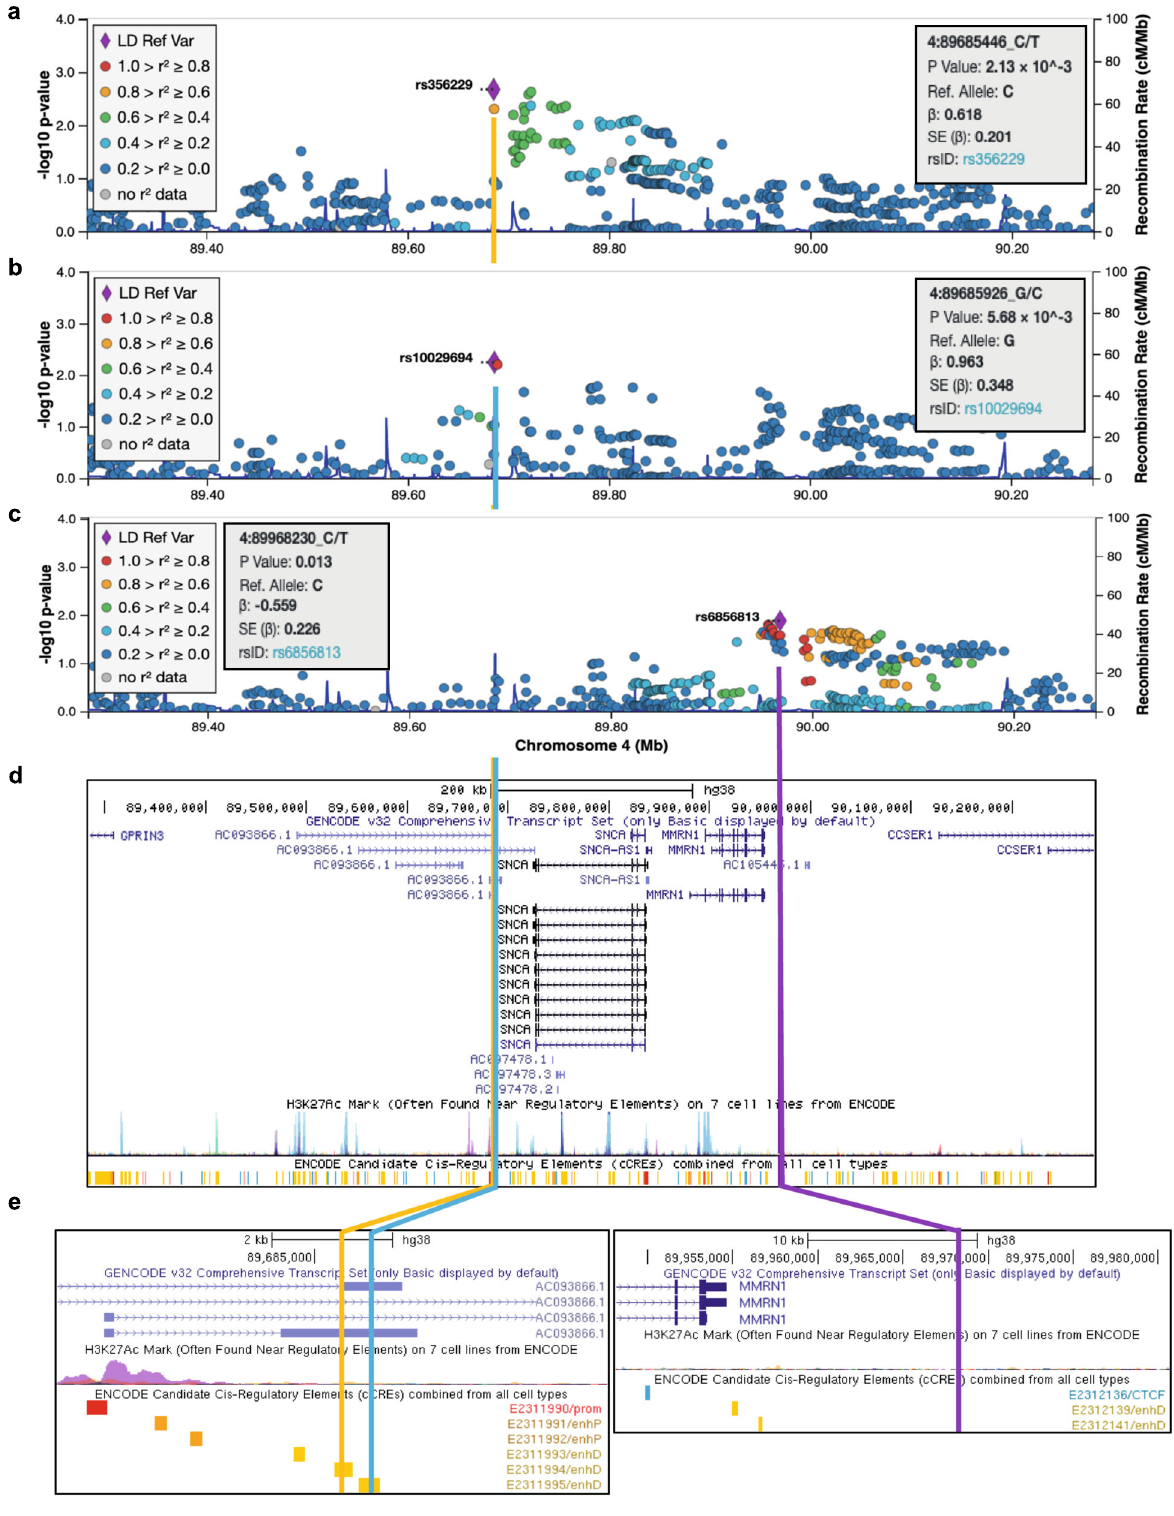
associated with increased PD risk (OR = 1.3, P = 3E − 42 with N >100,000 samples 23 ). We also detected an association between rs356229_C and PD in the present dataset (OR = 1.3, P = 0.04 with N = 802 samples; Table 2). That we estimated an effect size identical to GWAS, despite the enormous disparity in